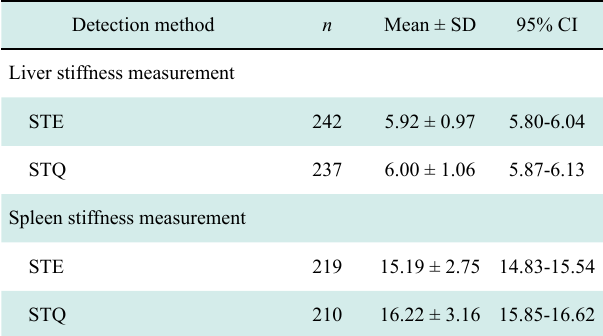
Table 4 Normal value of shear-wave velocity (kPa) assessed by different detection